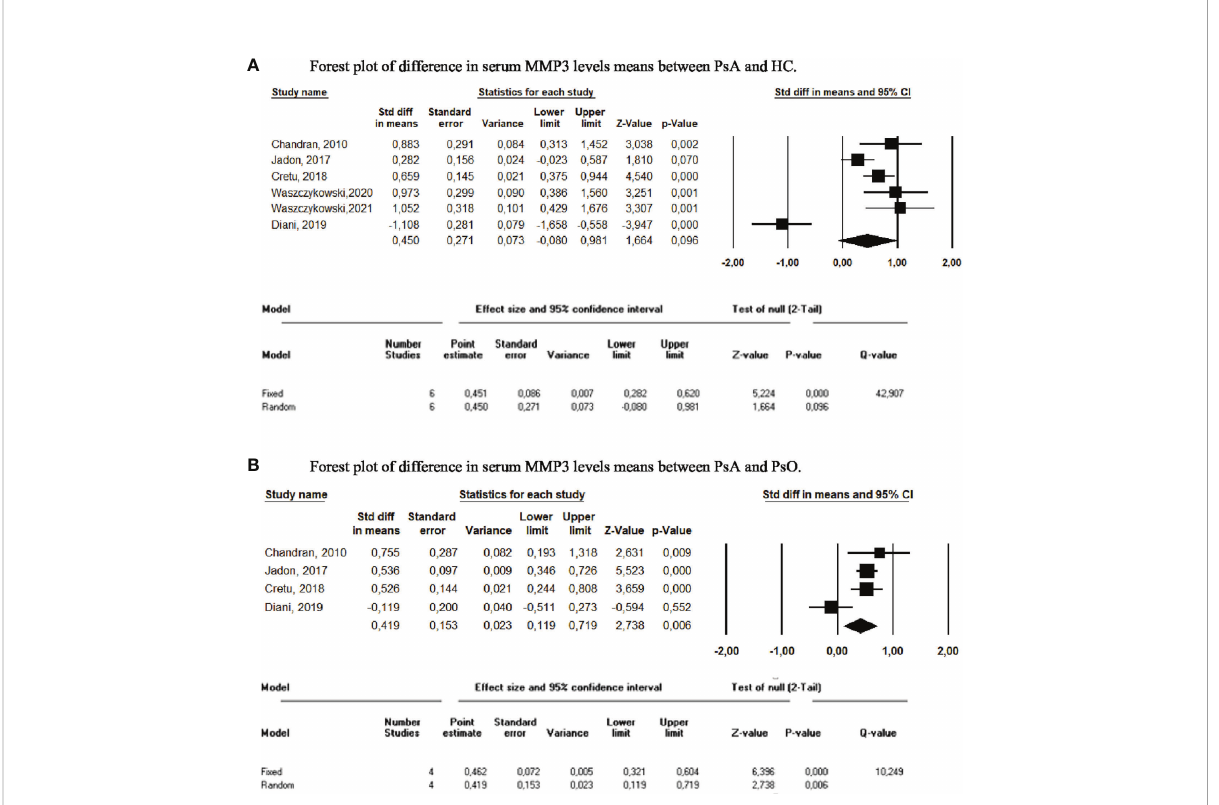
FIGURE 3 Meta-analysis of serum MMP3 levels. (A) Forest plot of difference in serum MMP3 levels means between PsA and HC. (B) Forest plot of difference in serum MMP3 levels means between PsA and